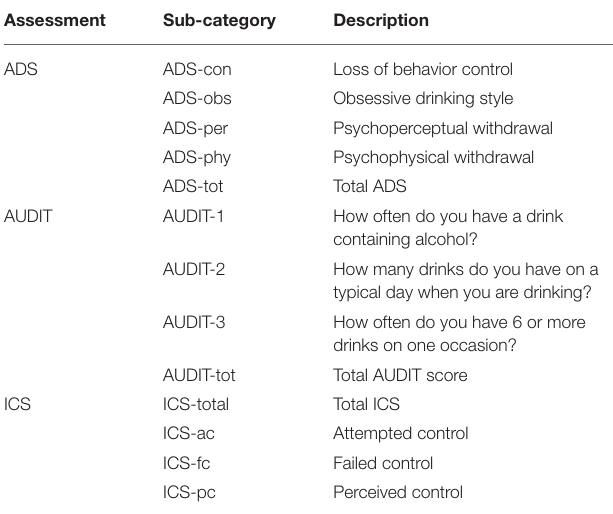
TABLE 2 | Behavioral assessments investigated for associations with DNA methylation.